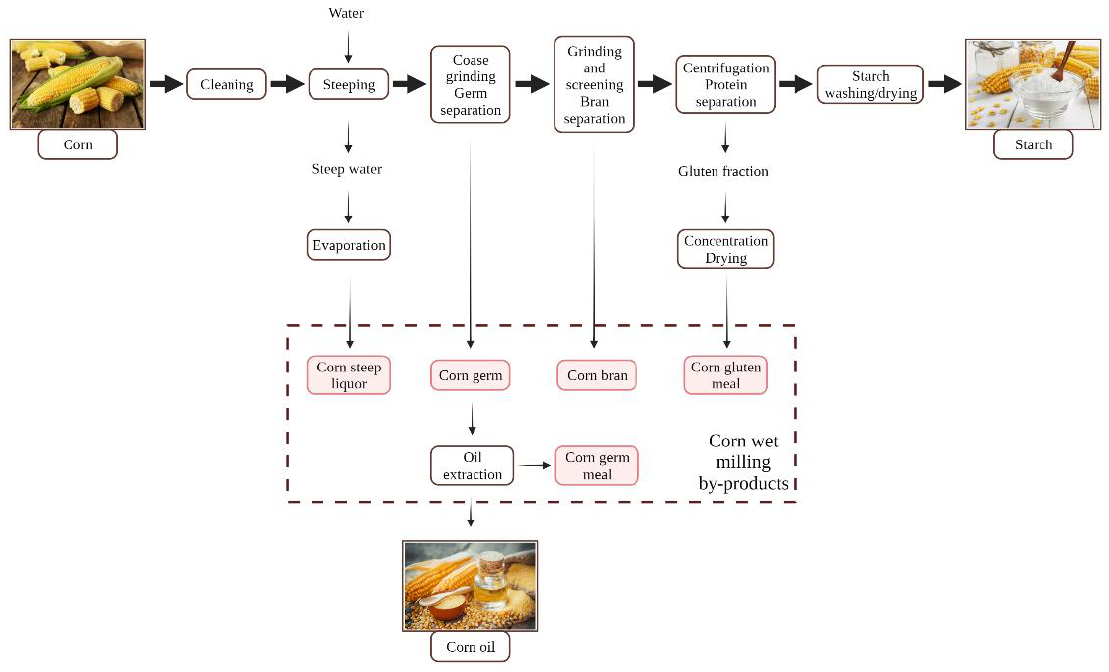
Figure 2. Types of by-products resulted after corn processing [11,17].